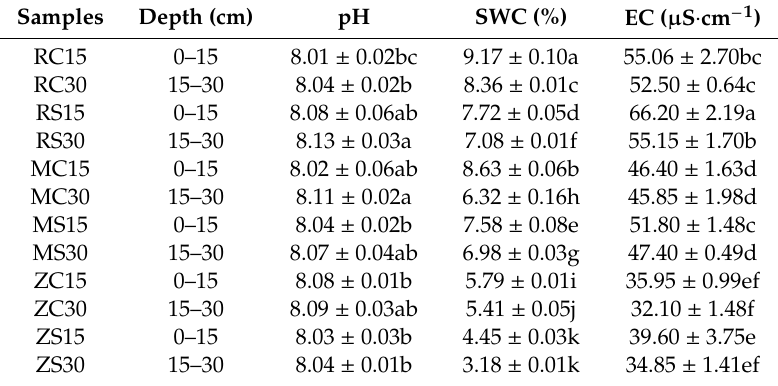
Table 1. Soil physicochemical characteristics of samples.